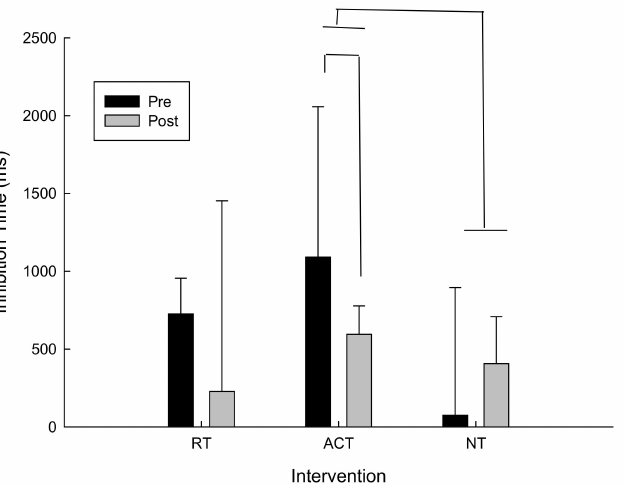
Figure 3. Inhibition time (incongruent–congruent) as a function of intervention and